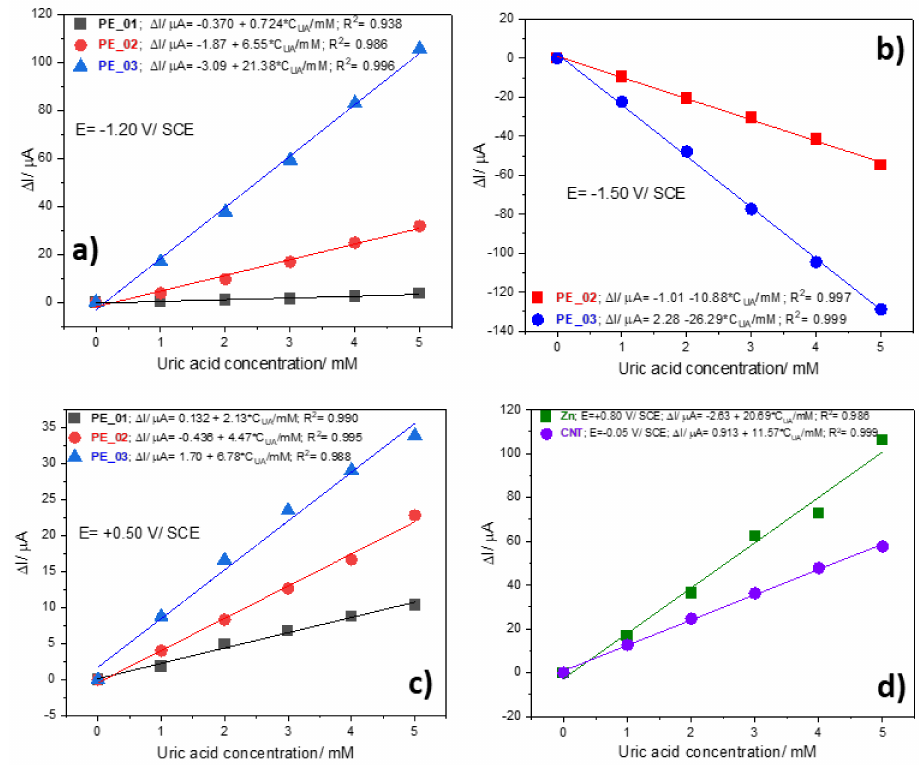
Figure 6. Calibration plots of useful current vs. UA concentrations recorded at: ( a ) E = − 1.20 V/SCE on PE_01, PE_02, and PE_03 electrodes; ( b ) E = − 1.50 V/SCE on PE_02 and PE_03 electrodes; ( c ) E = +0.50 V/SCE on PE_01, PE_02, and PE_03 electrodes; ( d ) E = +0.80 V/SCE on commercial Zn electrode, and E = − 0.05 V/SCE on CNT paste electrode.